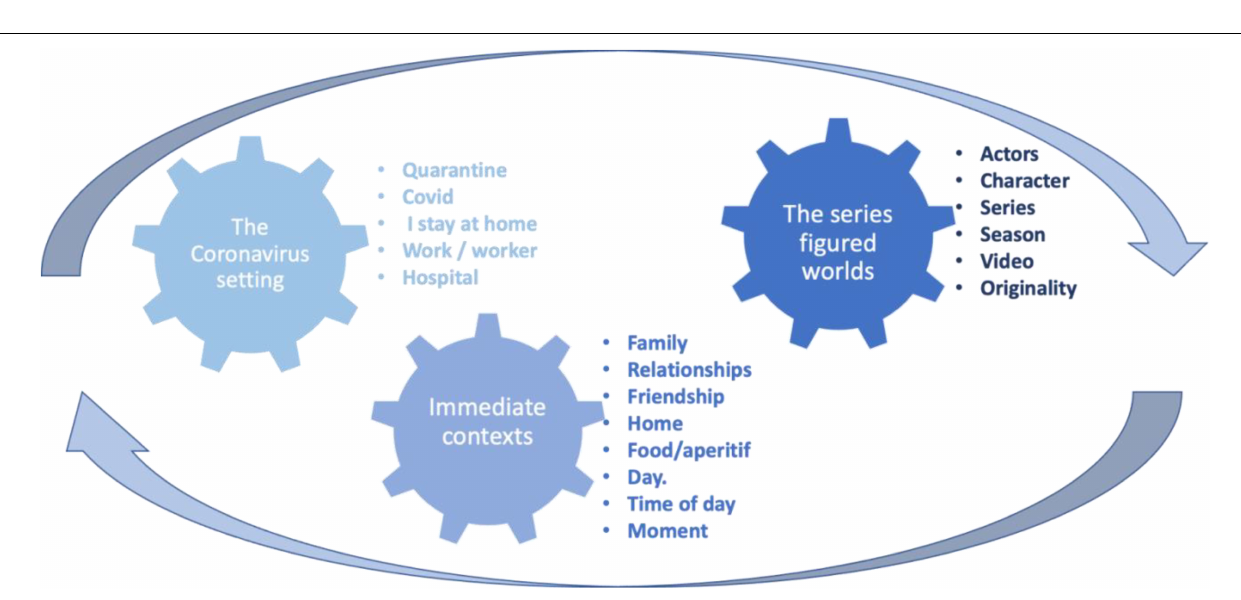
FIGURE 4 | Thematic nuclei and